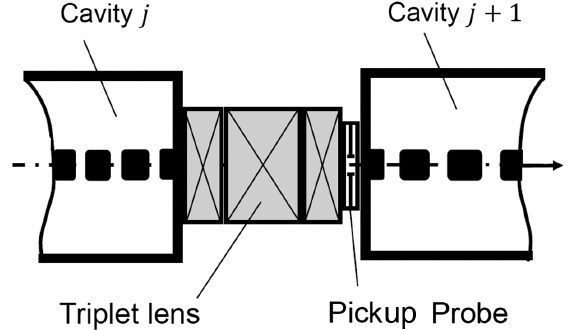
FIG. 14. Sectional view of an intertank section consisting of a bunch pickup probe for beam diagnostics and of a compact quadrupole triplet. The length between neighbored cavities must be minimized for an optimum longitudinal beam